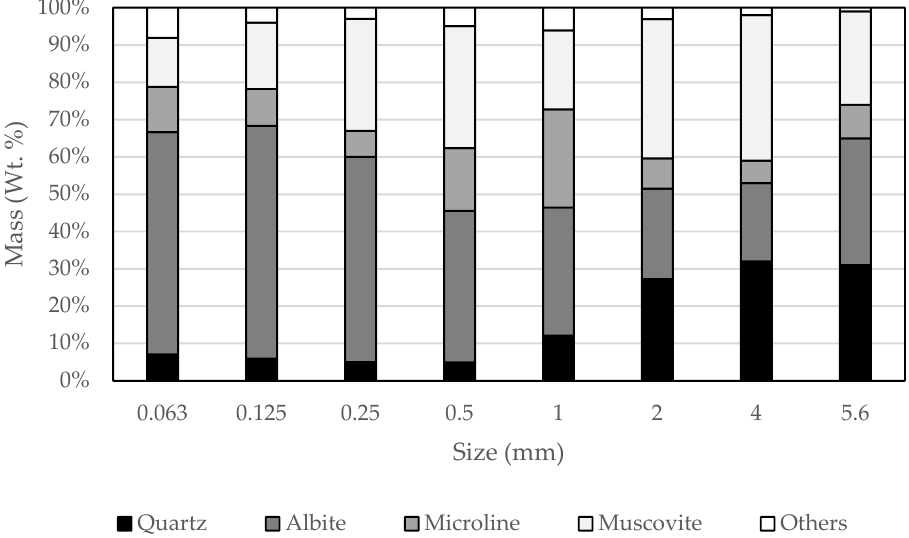
Figure 7. Mineral abundance expressed in wt.% in different size fractions for 30% of compression ratio for quartz, albite, microcline, and muscovite, for sample 1.